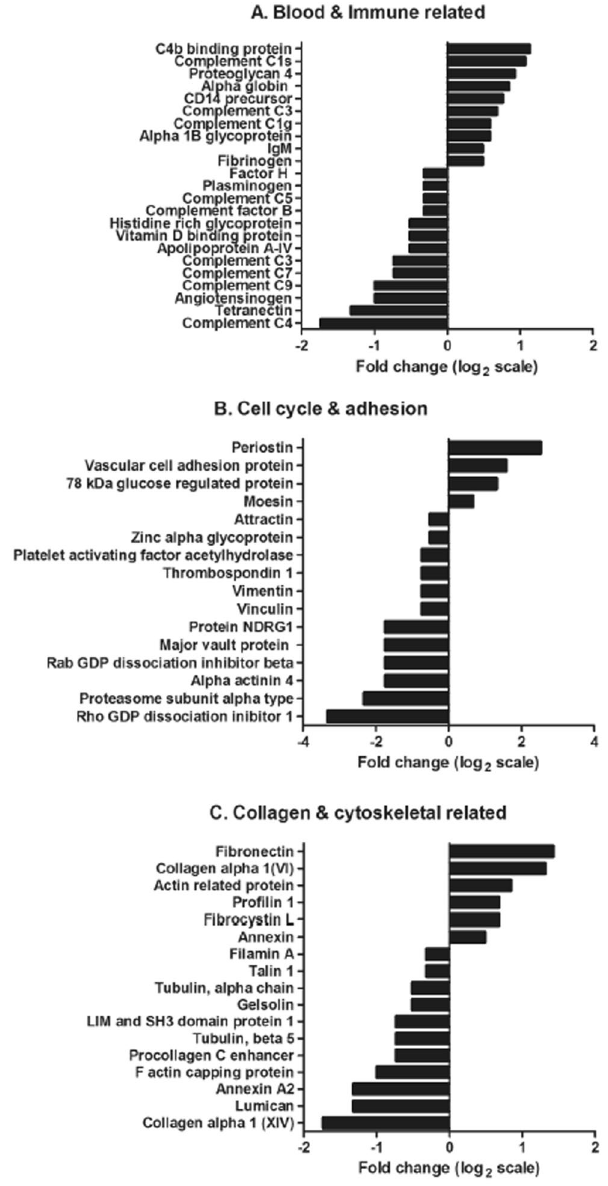
Figure 5. Expression profile of proteins identified within the peritoneal fluid relating to ( A ) blood, coagulation and the immune system, ( B ) cell cycle and cell adhesion, ( C ) collagen and cytoskeletal structure. The fold change, represented on a log 2 scale, was calculated based on the differences in protein concentration (emPAI values) between the uninfected and infected peritoneal fluid